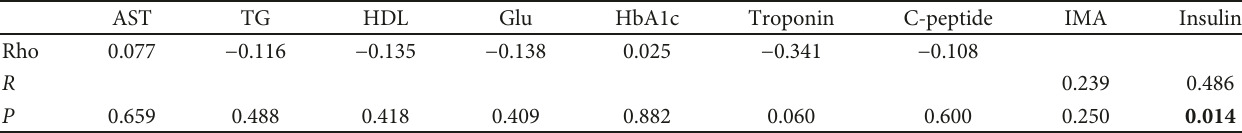
Table 2: Relationship between ECV and biochemical characteristics.